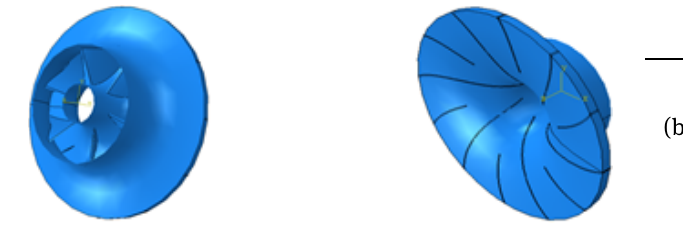
Figure 3: Centrifugal compressor wheel: (a) open; (b) closed